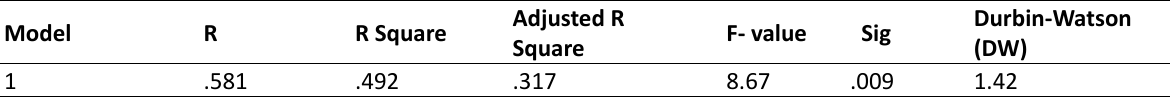
Table 6. Multiple Regression regarding Impact of Ten (10) dimensions of OC on the JP Model